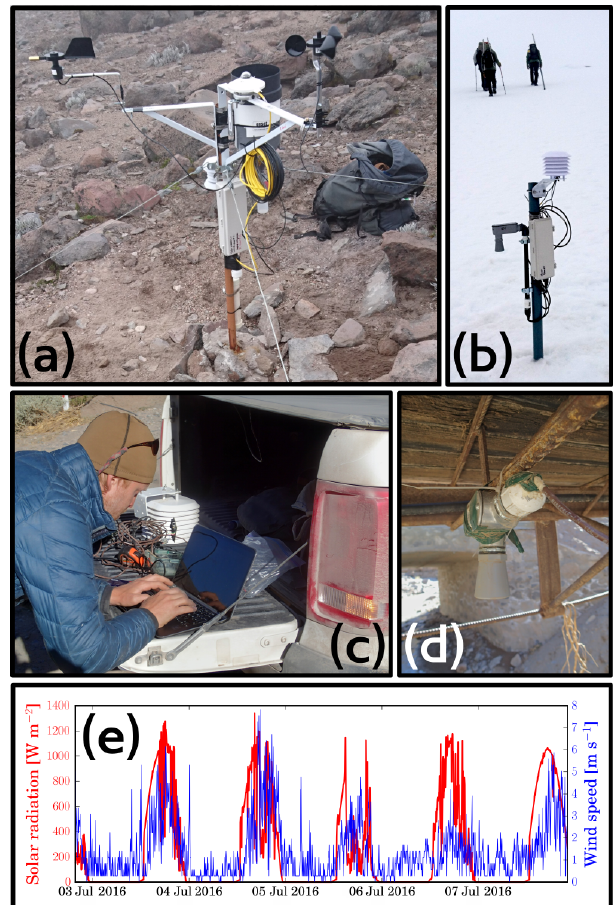
Figure 4. Example ALog deployments. (a) Weather station with anemometer, pyranometer, wind vane, thermistor, and tipping- bucket rain gage, to measure high-desert climate parameters. (b) Glacier monitoring station with look-down ultrasonic sensor, thermistor, and relative humidity sensor, to monitor ablation and its drivers. (c) Downloading field data by copying and pasting an ASCII text file from the SD card. (d) Look-down ultrasonic sensor as a simple stream gauge; despite the destruction of the monitoring system in a historic flood event, the data file remained saved and uncorrupted on the SD card. (e) Solar radiation and wind speed co- vary at the station in (a) ; wind speed lags radiation, indicative of surface-heating-driven convective winds in this high-altitude arid